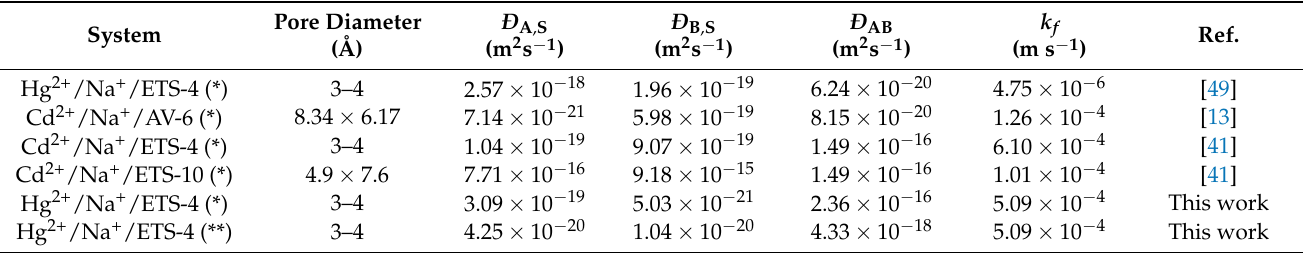
Table 4. Comparison between MS diffusivities and convective mass transfer coefficient optimized in this work and published in the